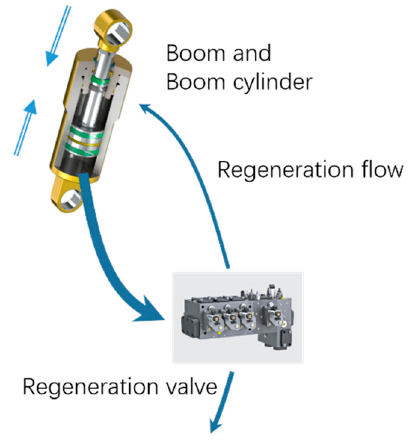
Figure 4. Schematic of the flow regeneration system.